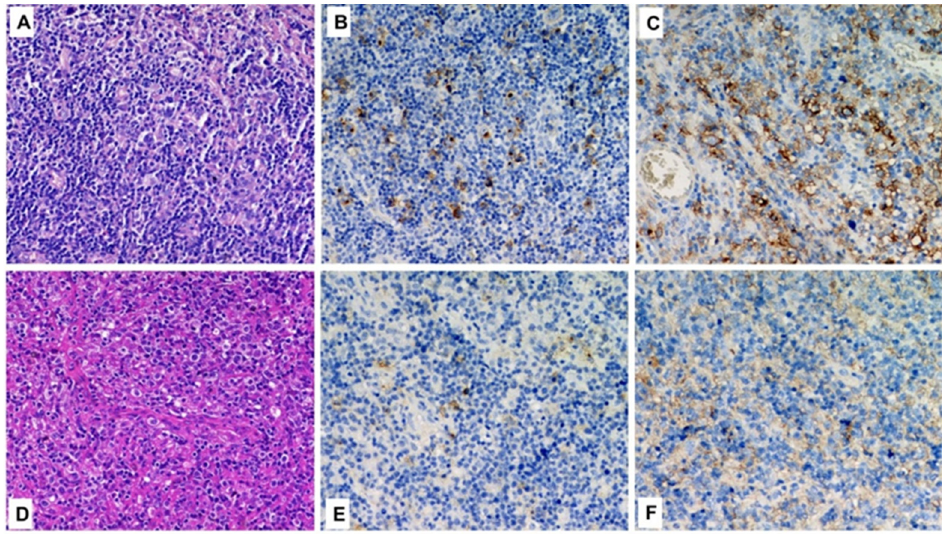
Figure 1. Histological comparison between cHL ( A – C ) and DLBCL ( D – F ) in the same patient (case n.1). In each row, from left to right, hematoxylin-eosin, CD30 and PD-L1 (original magnification 200×).